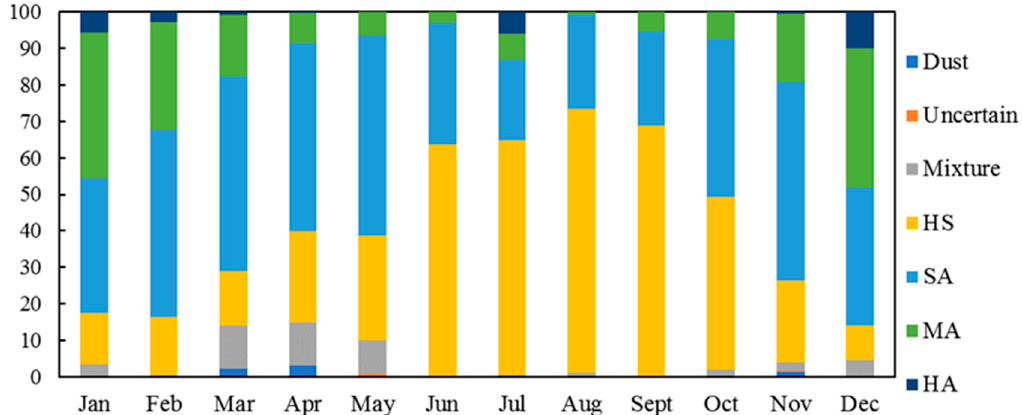
Figure 13. The frequency of seasonal variation of aerosol types in Lake Taihu from 2005 to 2018. The HA, MA, SA, and HS represent highly absorbing, moderately absorbing, slightly absorbing, and highly scattering fine-mode aerosols,